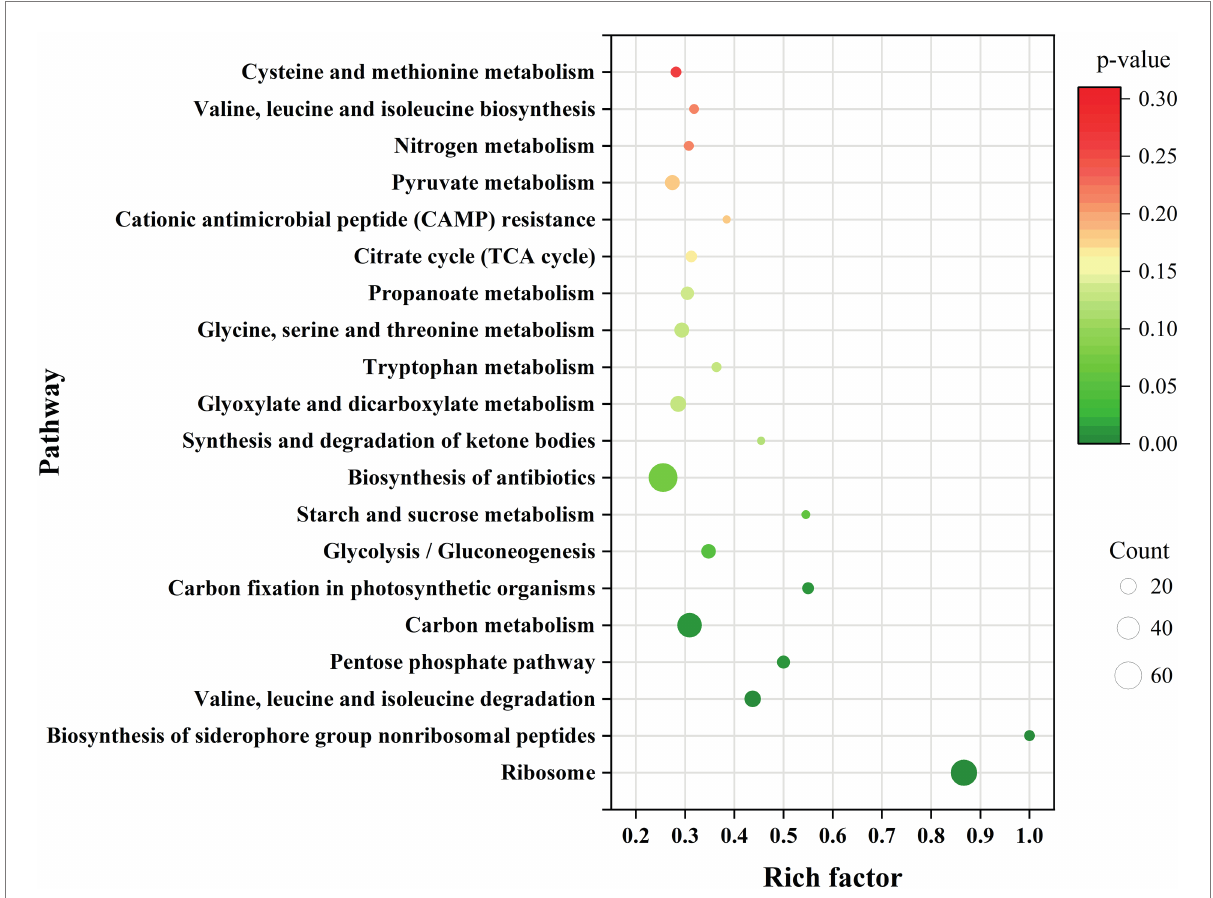
FIGURE 5 Scatterplot of top 20 KEGG pathway enrichment for differentially expressed genes (DEGs) in PD-pdeR. Data was displayed with the parameters of gene count, gene ratio and value of p